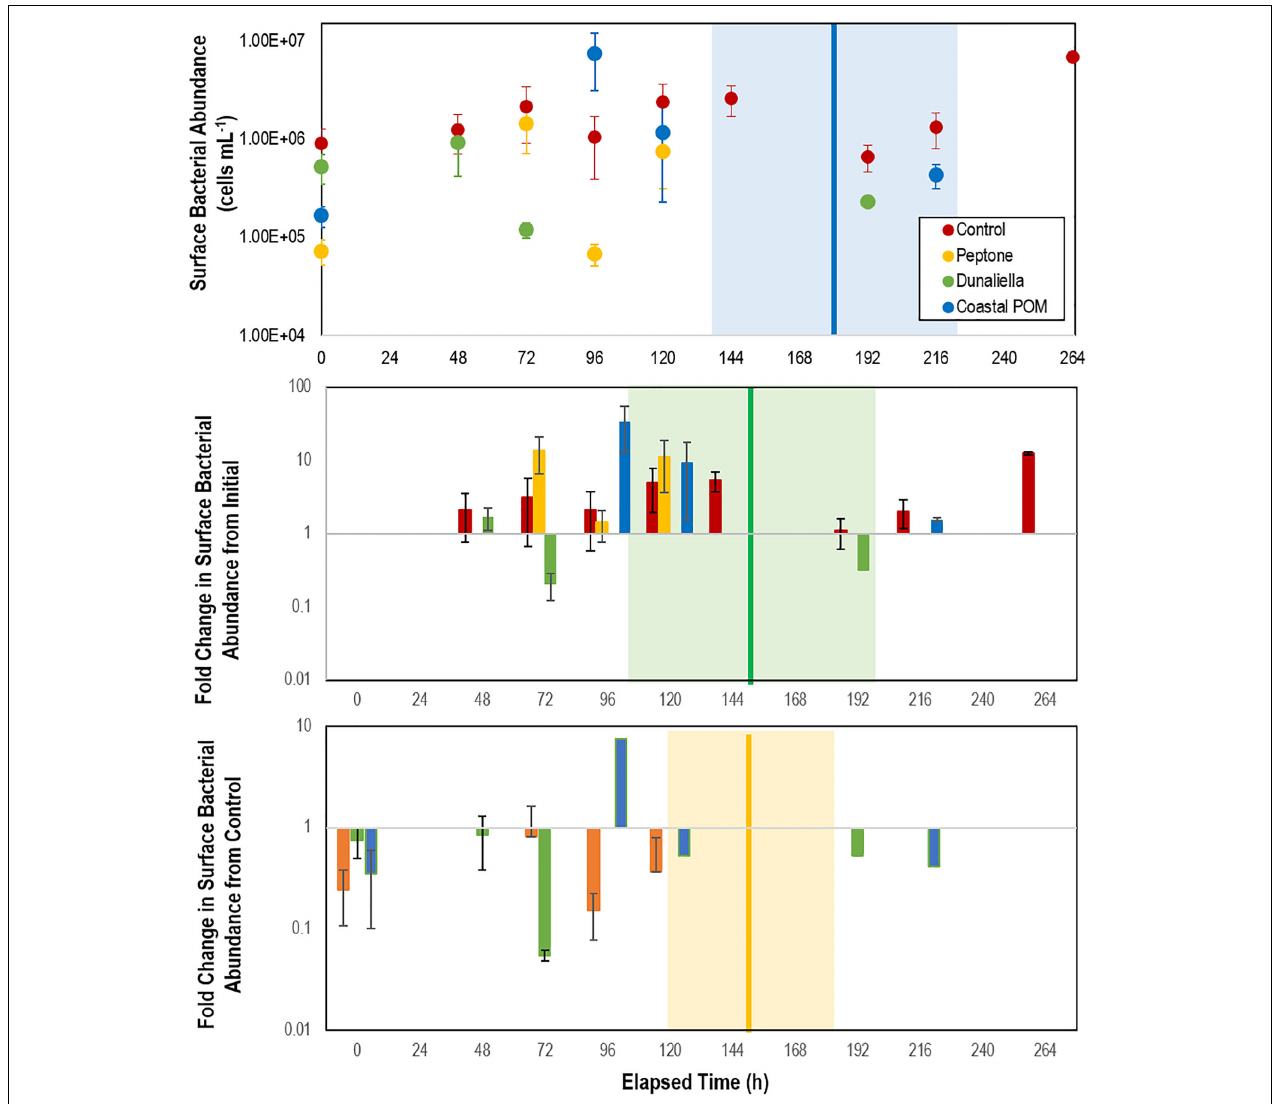
FIGURE 3 | Abundance of bacteria in proximity to P. ochraceus surfaces (top), fold change from initial (middle), and relative to controls (bottom). During first 10 days of experiment in response to organic matter enrichment ( n = 5 for each treatment) as assessed by SYBR Gold staining and epifluorescence microscopy. Control specimens are indicated in red, while the mean of specimens that wasted in Peptone, Dunaliella tertiolecta POM, and Coastal POM are indicated separately. The solid vertical line on the top panel represents the mean time that asteroids developed lesions in the coastal POM treatment, the solid line on the middle panel represents the mean time for lesion development in Dunaliella tertiolecta POM treatments, and solid line on the bottom panel represents the mean time for lesion development in peptone treatments (separated between panels for clarity). The shaded regions represent lesion development standard error for respective